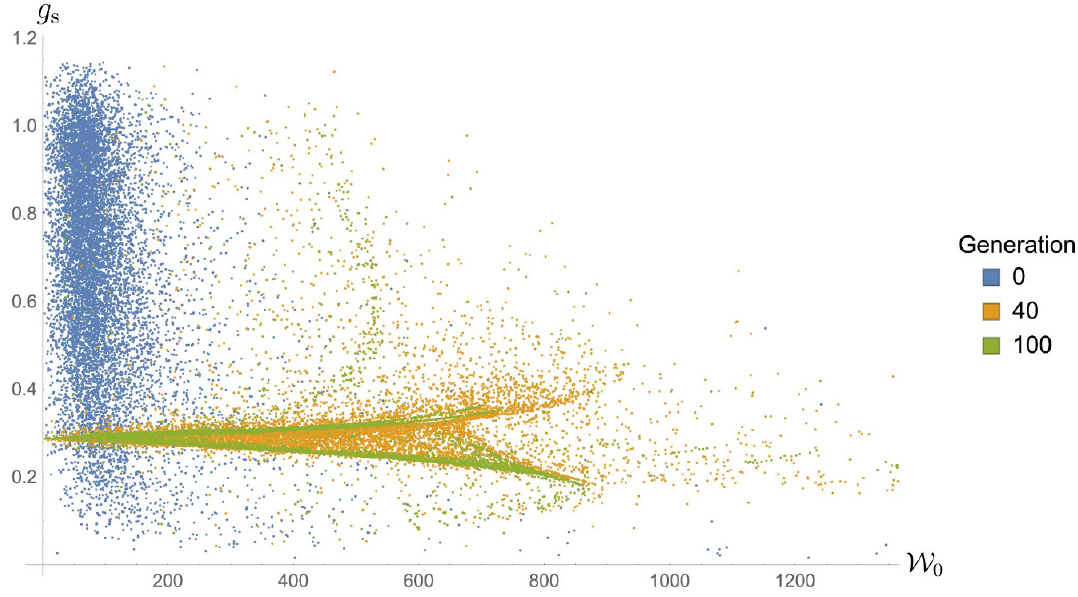
Figure 9 . Evolution of the distribution of g s and W 0 for three generations.